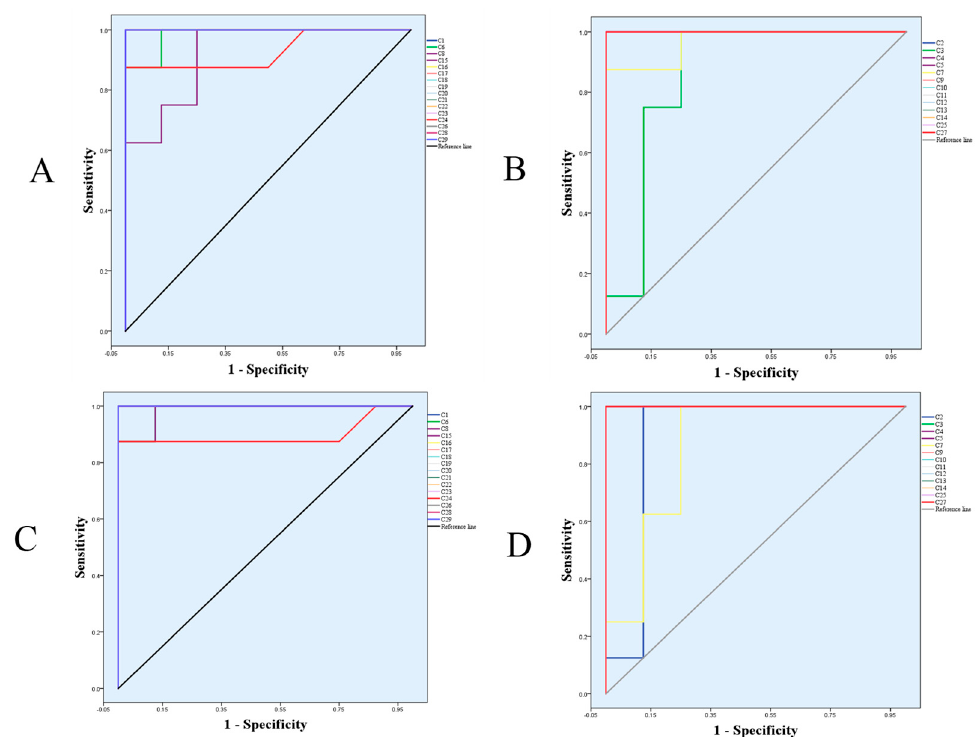
Figure 8. OPLS-DA S- plots of serum and hippocampus metabolic profiling. (Numbers marked are consistent with the No. of each biomarker in Table 1).